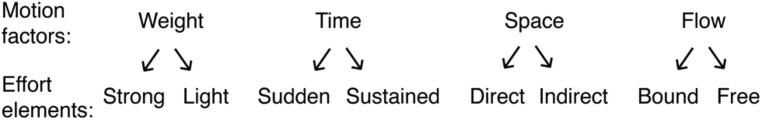
The four motion factors and their associated effort elements – the primary components of effort-shape analysis.